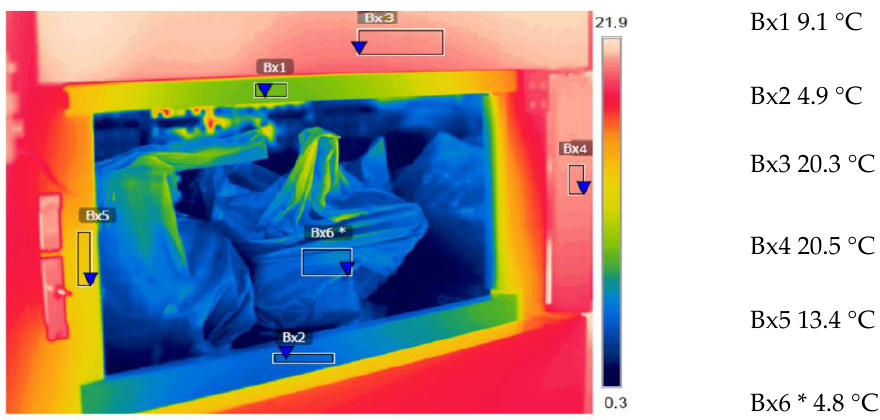
Figure 10. Thermogram for the loaded chamber 2 of the cooling module .